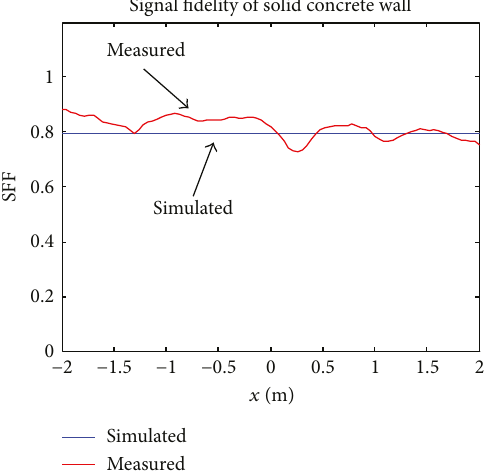
Figure 11: SFF of the received radar signals from the solid concrete